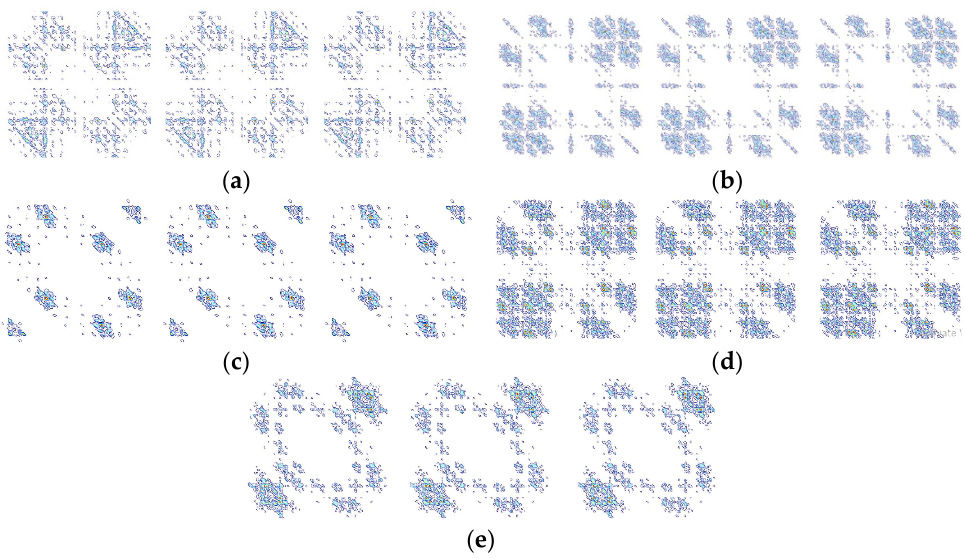
Figure 17. Examples of the generated 2D bi-spectrum counter maps of ( a ) bearing roller wearing fault, ( b ) inner race wearing fault, ( c ) outer race wearing fault, ( d ) normal condition, and ( e ) centrifugal pump impeller wearing fault condition using the bi-spectrum-based technique in [80].